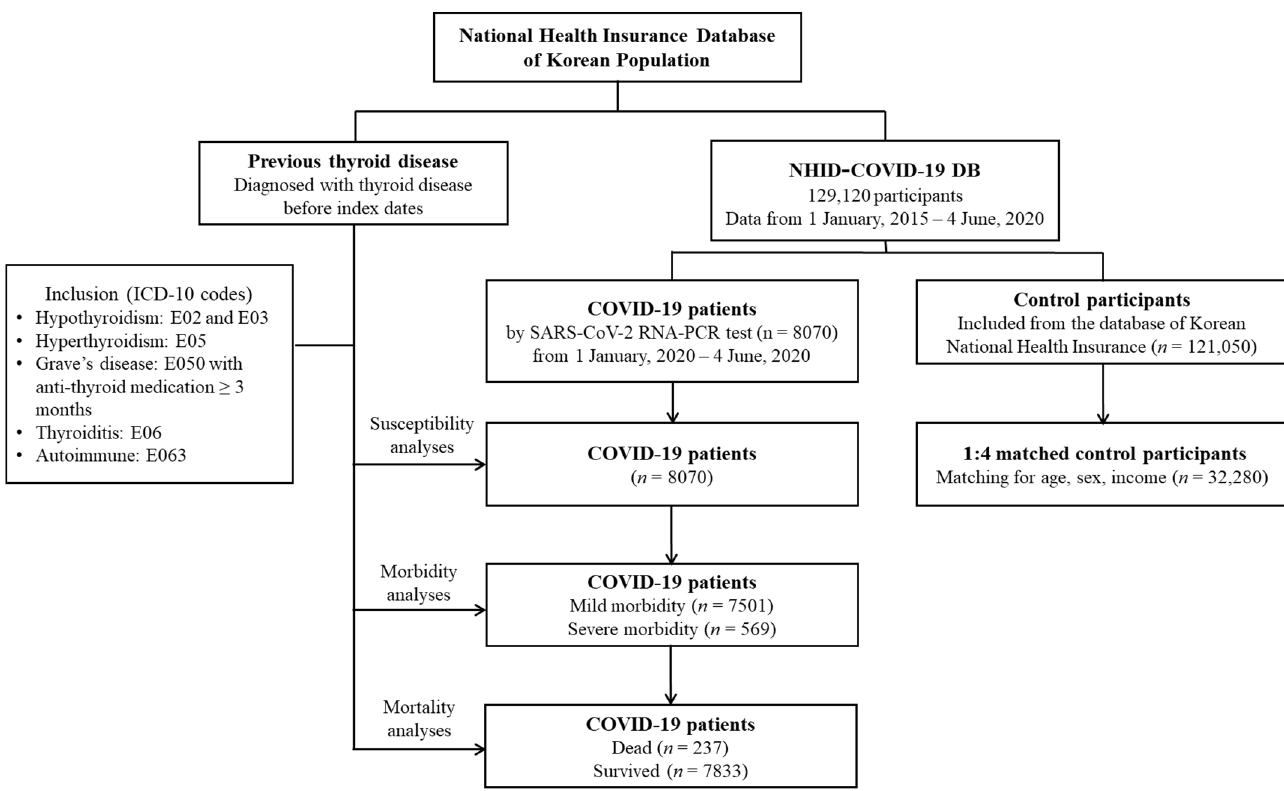
Figure 1. A schematic illustration of the participant selection process that was used in the present study. Of a total of 129,120 participants, 8070 COVID-19 patients were matched with 32,280 control participants for age, sex, and income. ICD-10: International Classification of Diseases, revision 10.